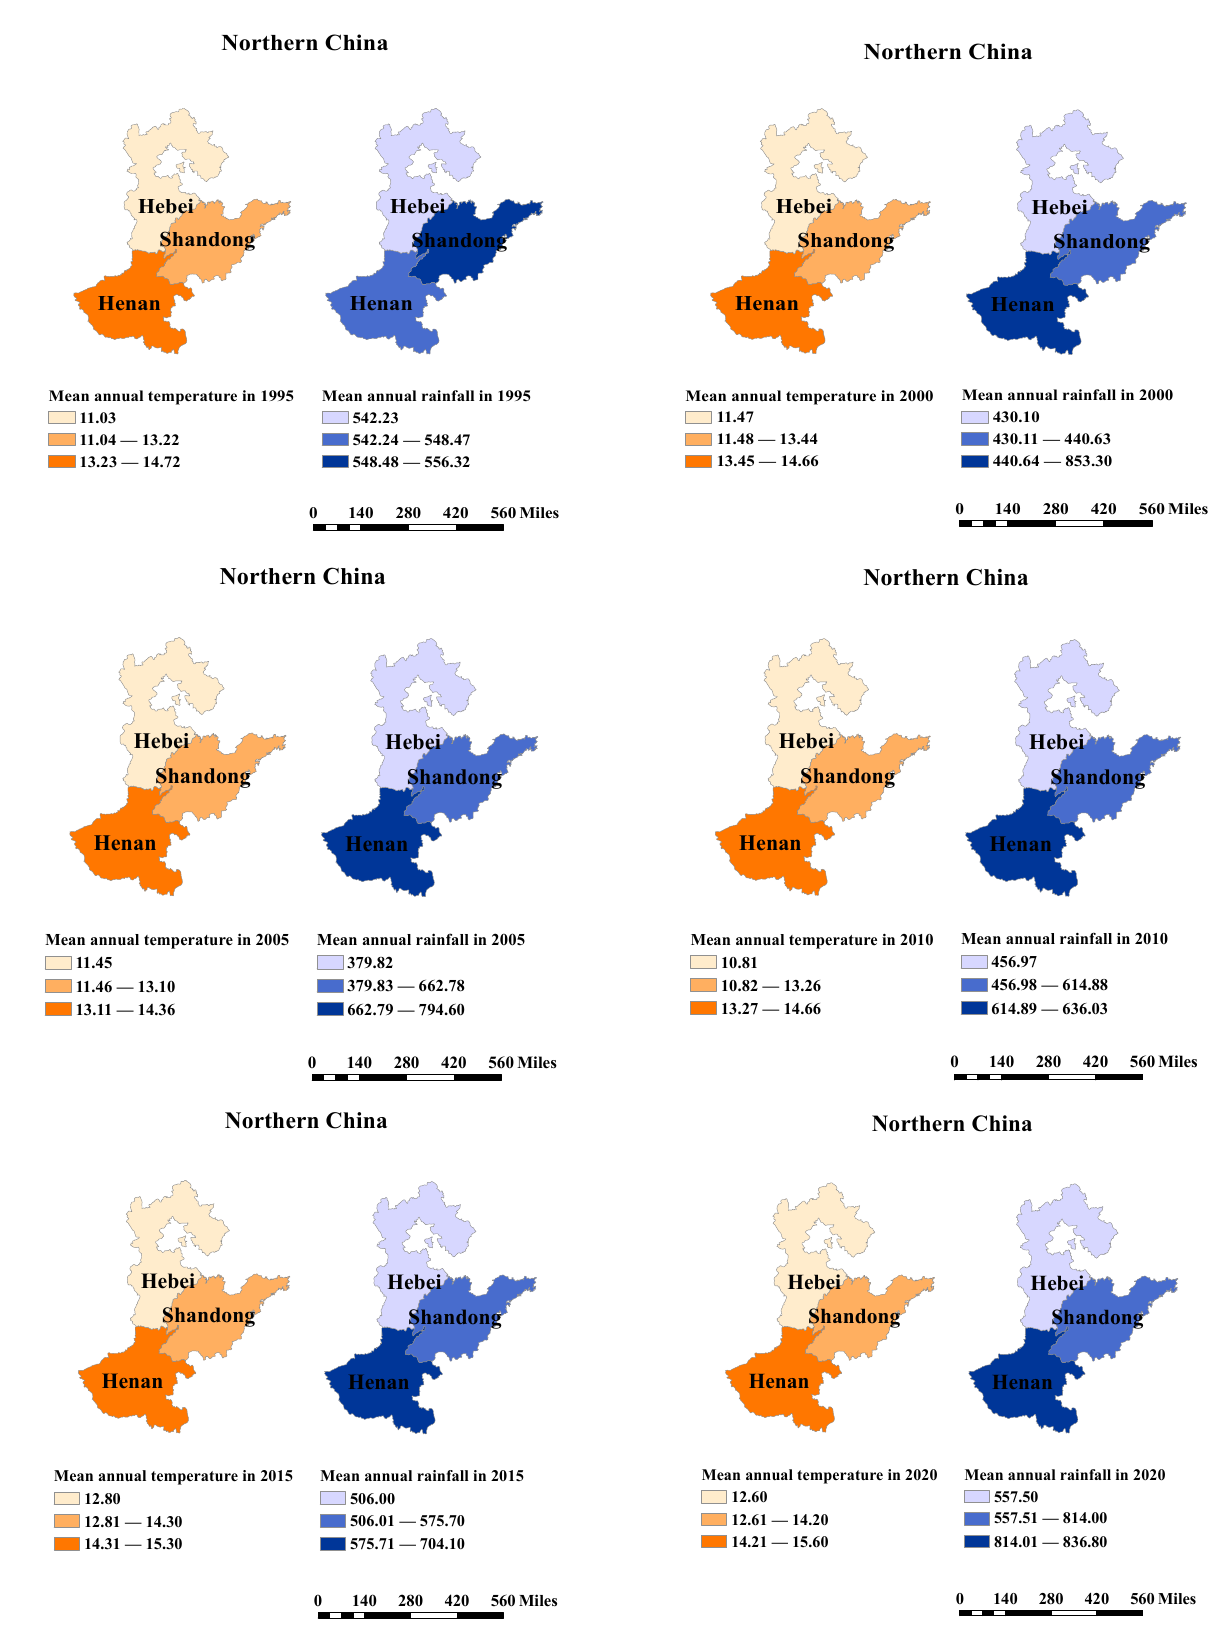
Figure 1. The distribution of wheat production (10,000 tons) in Hebei, Henan, and Shandong Provinces.